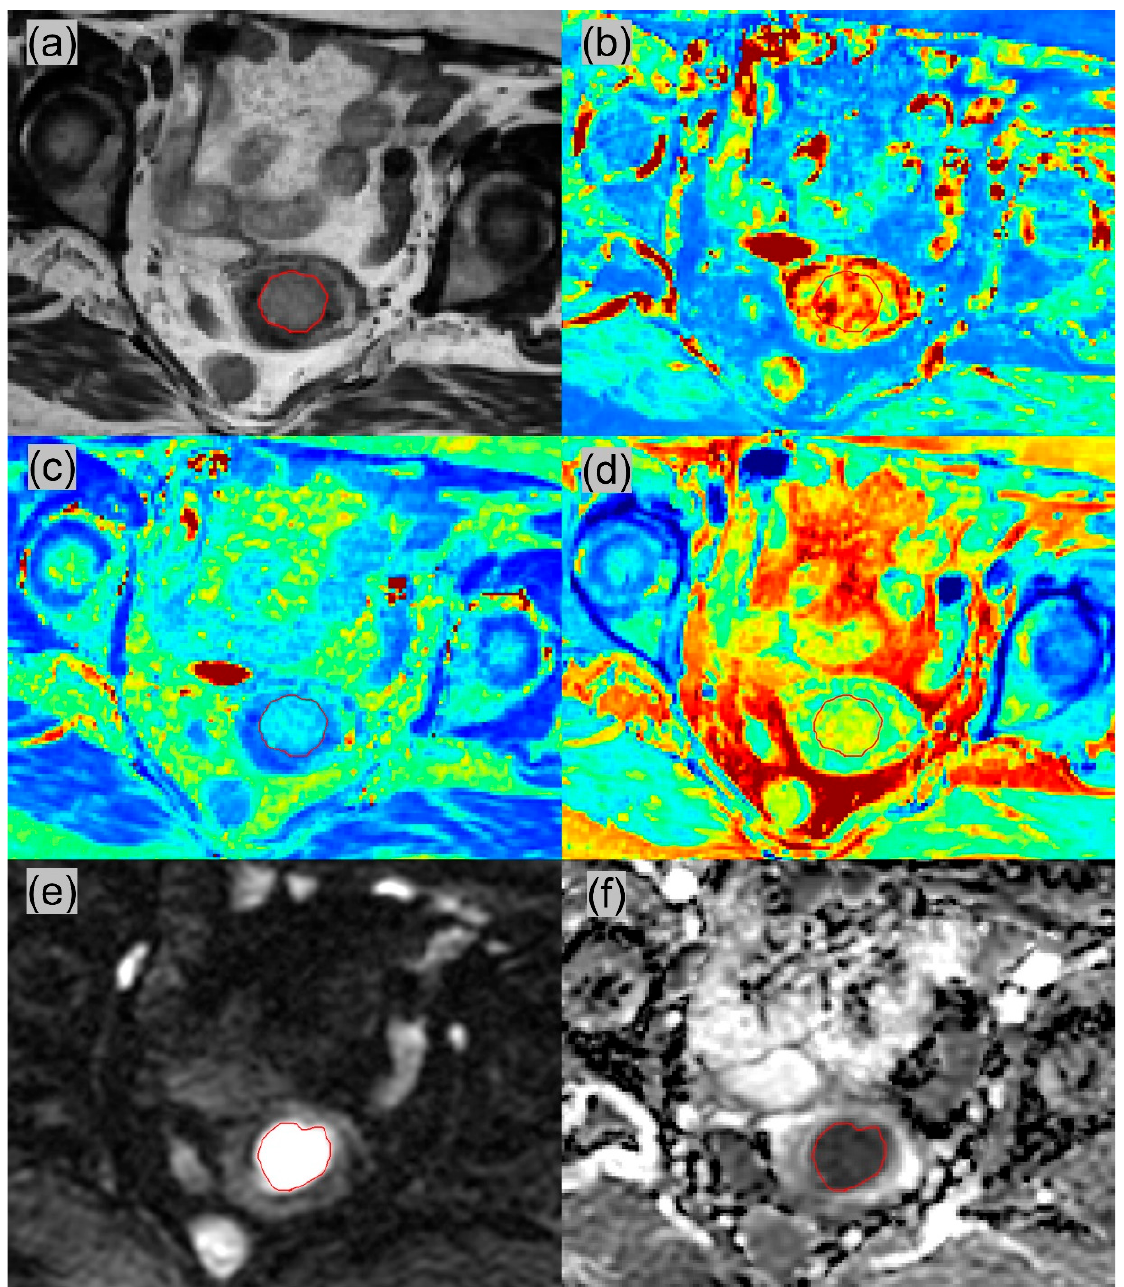
Figure 3. A 66-year-old woman with well-differentiated G2, FIGO stage II endometrioid adenocar- cinoma. The tumor had superficial myometrial invasion, cervical stromal invasion and lymphovas- cular invasion. ( a ) Synthetic T2-weighted image; ( b ) T1 map; ( c ) T2 map; ( d ) PD map; ( e ) diffusion- weighted image with b = 800; ( f ) ADC map. The ROI was delineated on Synthetic T2WI and DWI. The mean value of all voxels within the ROIs: T1 = 1225.7 msec; T2 = 104.8 msec; PD = 85.7 pu; ADC = 0.913 × 10 − 3 mm 2